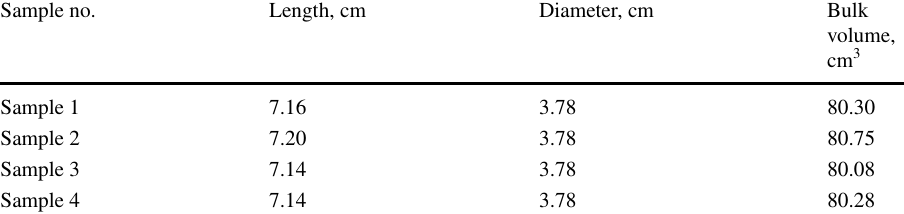
Table 7 Petrophysical characteristics of core samples (Ullah 2013): Core dimensions